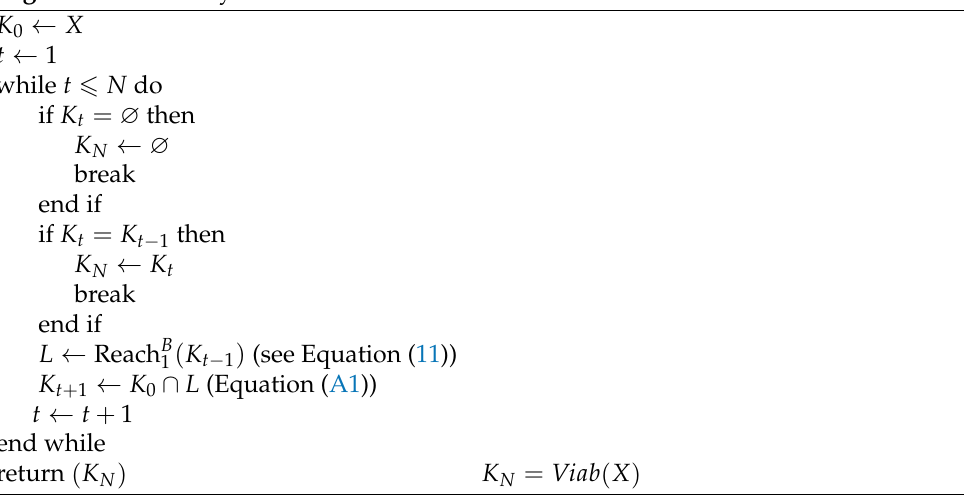
Algorithm 2 Viability Kernel